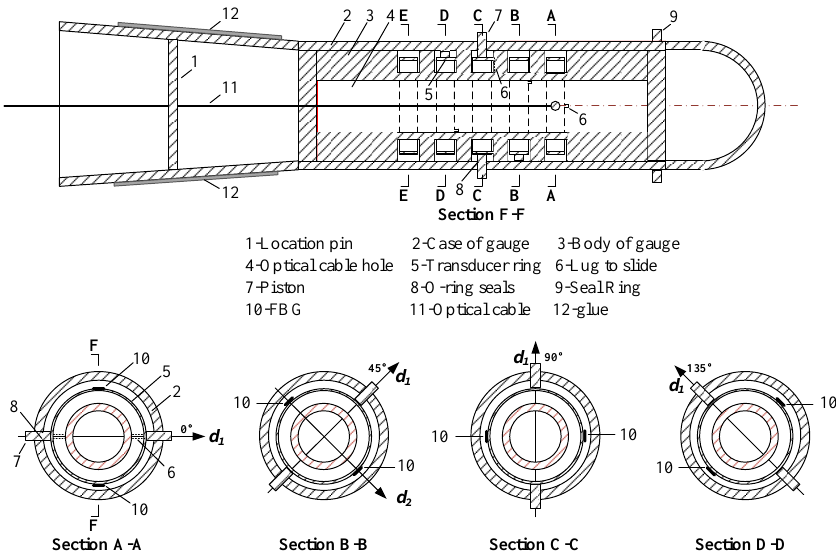
Figure 4. Drawing of principle parts of the FBG borehole deformation sensor.